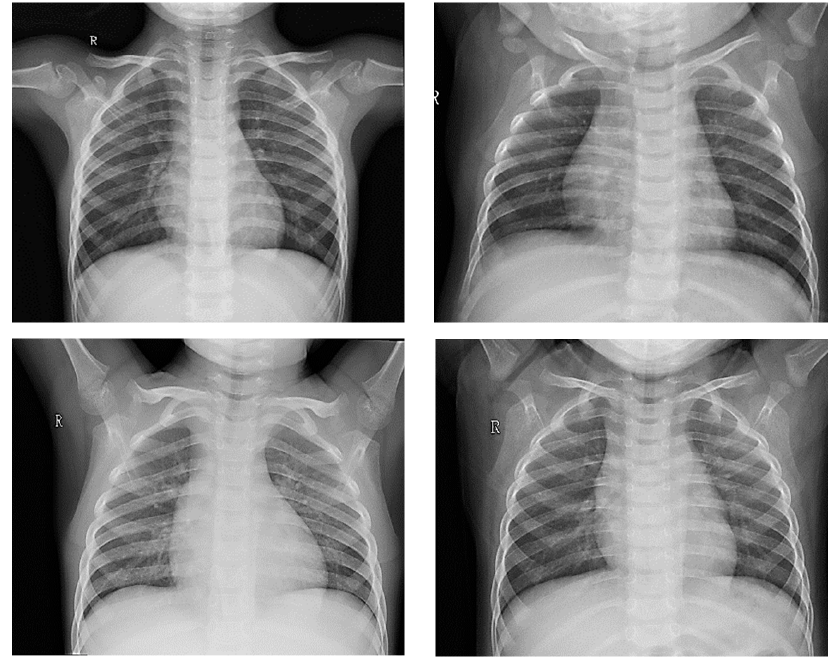
Figure 1. Healthy human CXRs used in the training of the CNN model [12–14].